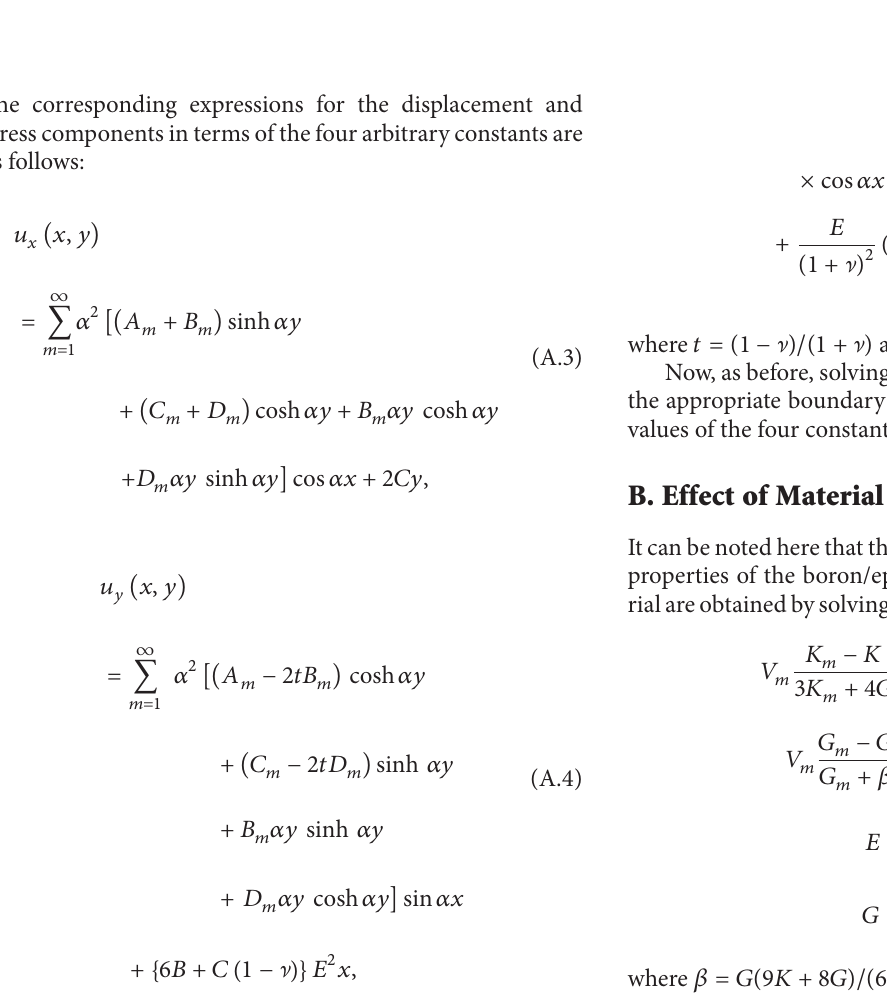
Figure 9: Comparison of solutions of the lateral stress component at the section, 𝑦/𝑏 = 1 by analytical and FE